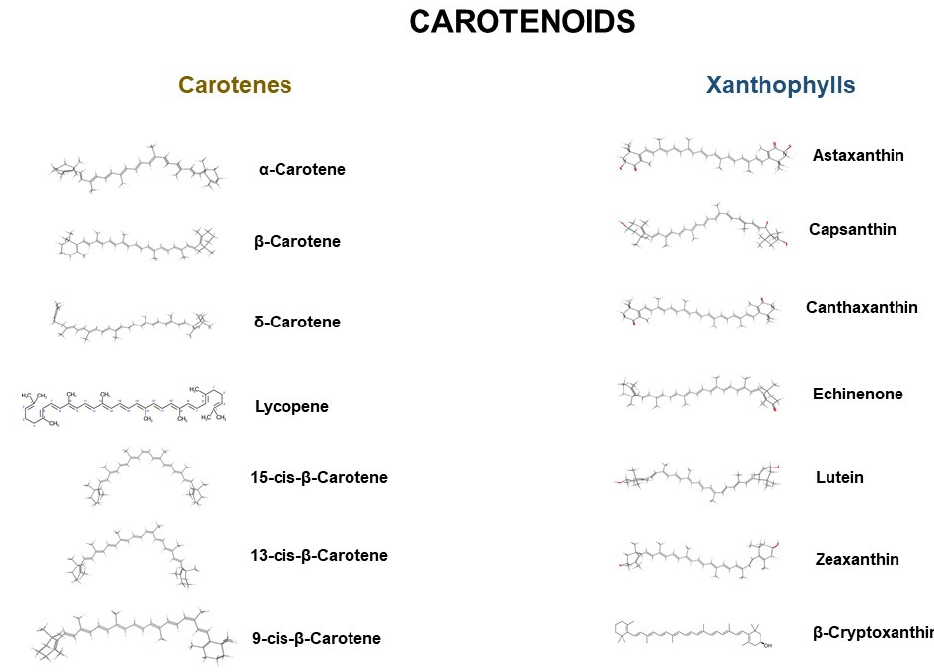
Figure 1. Representative chemical structures of carotenoids.